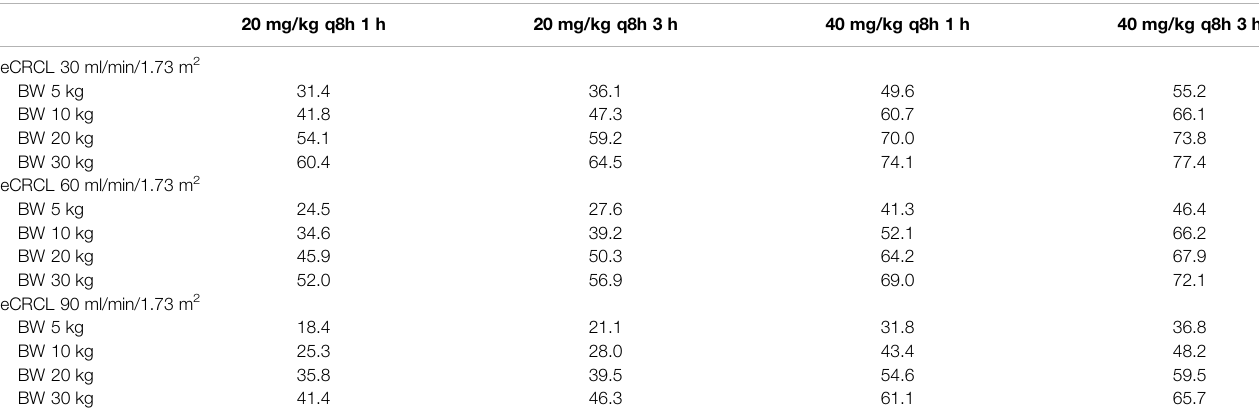
TABLE 6 | Percentage of children attaining 100% T > MIC according to renal function.